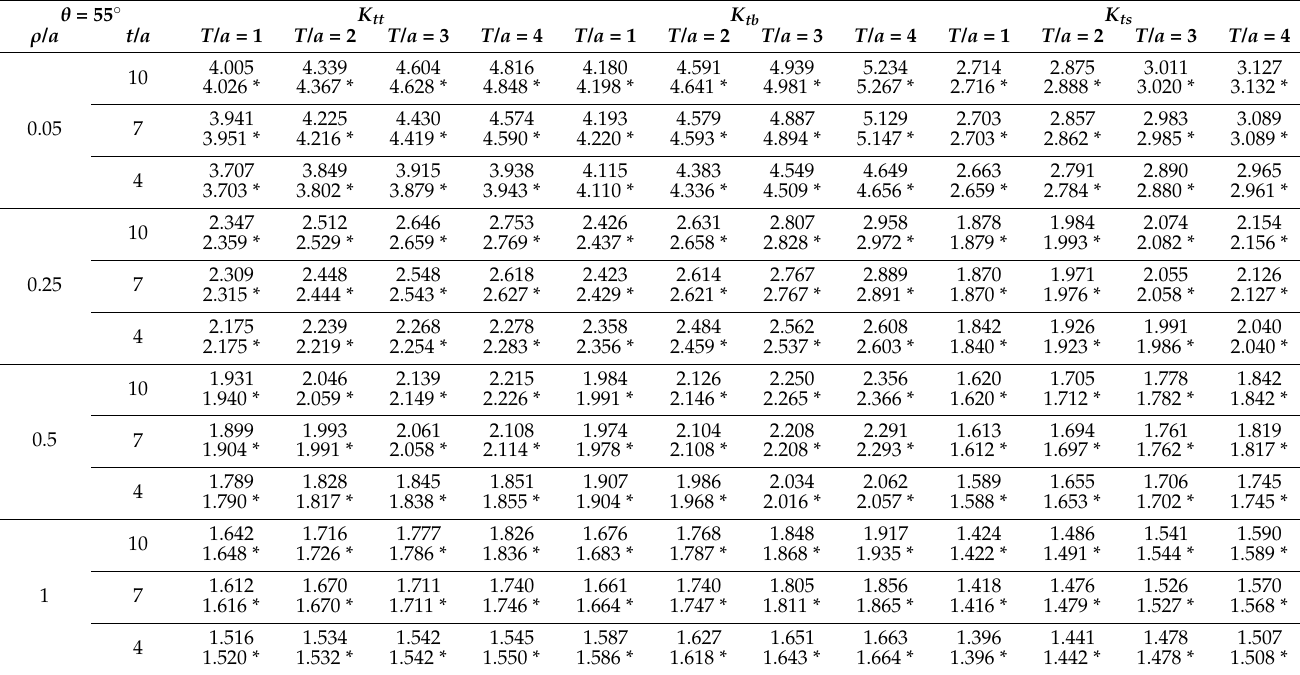
Table 7. Comparison of SCF’s values calculated using Equations (A1)–(A3) (*) to the corresponding FEM results for various T/a ratios, while θ = 55 ◦